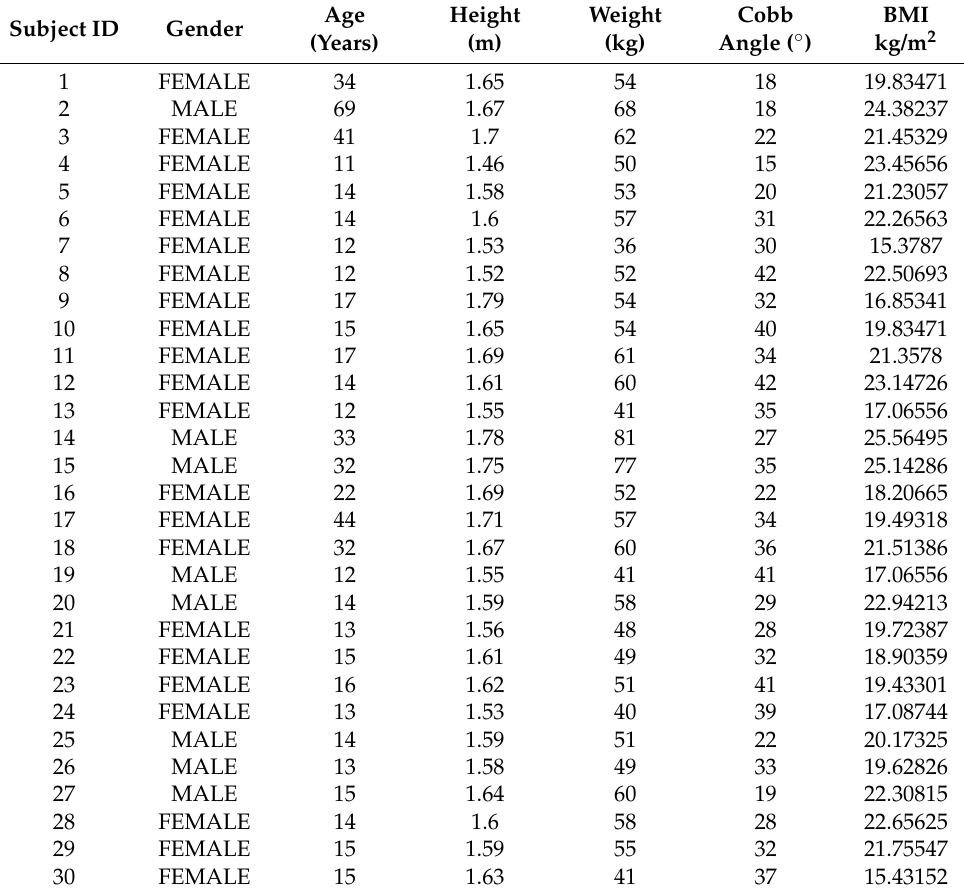
Table A1. Characteristics of all